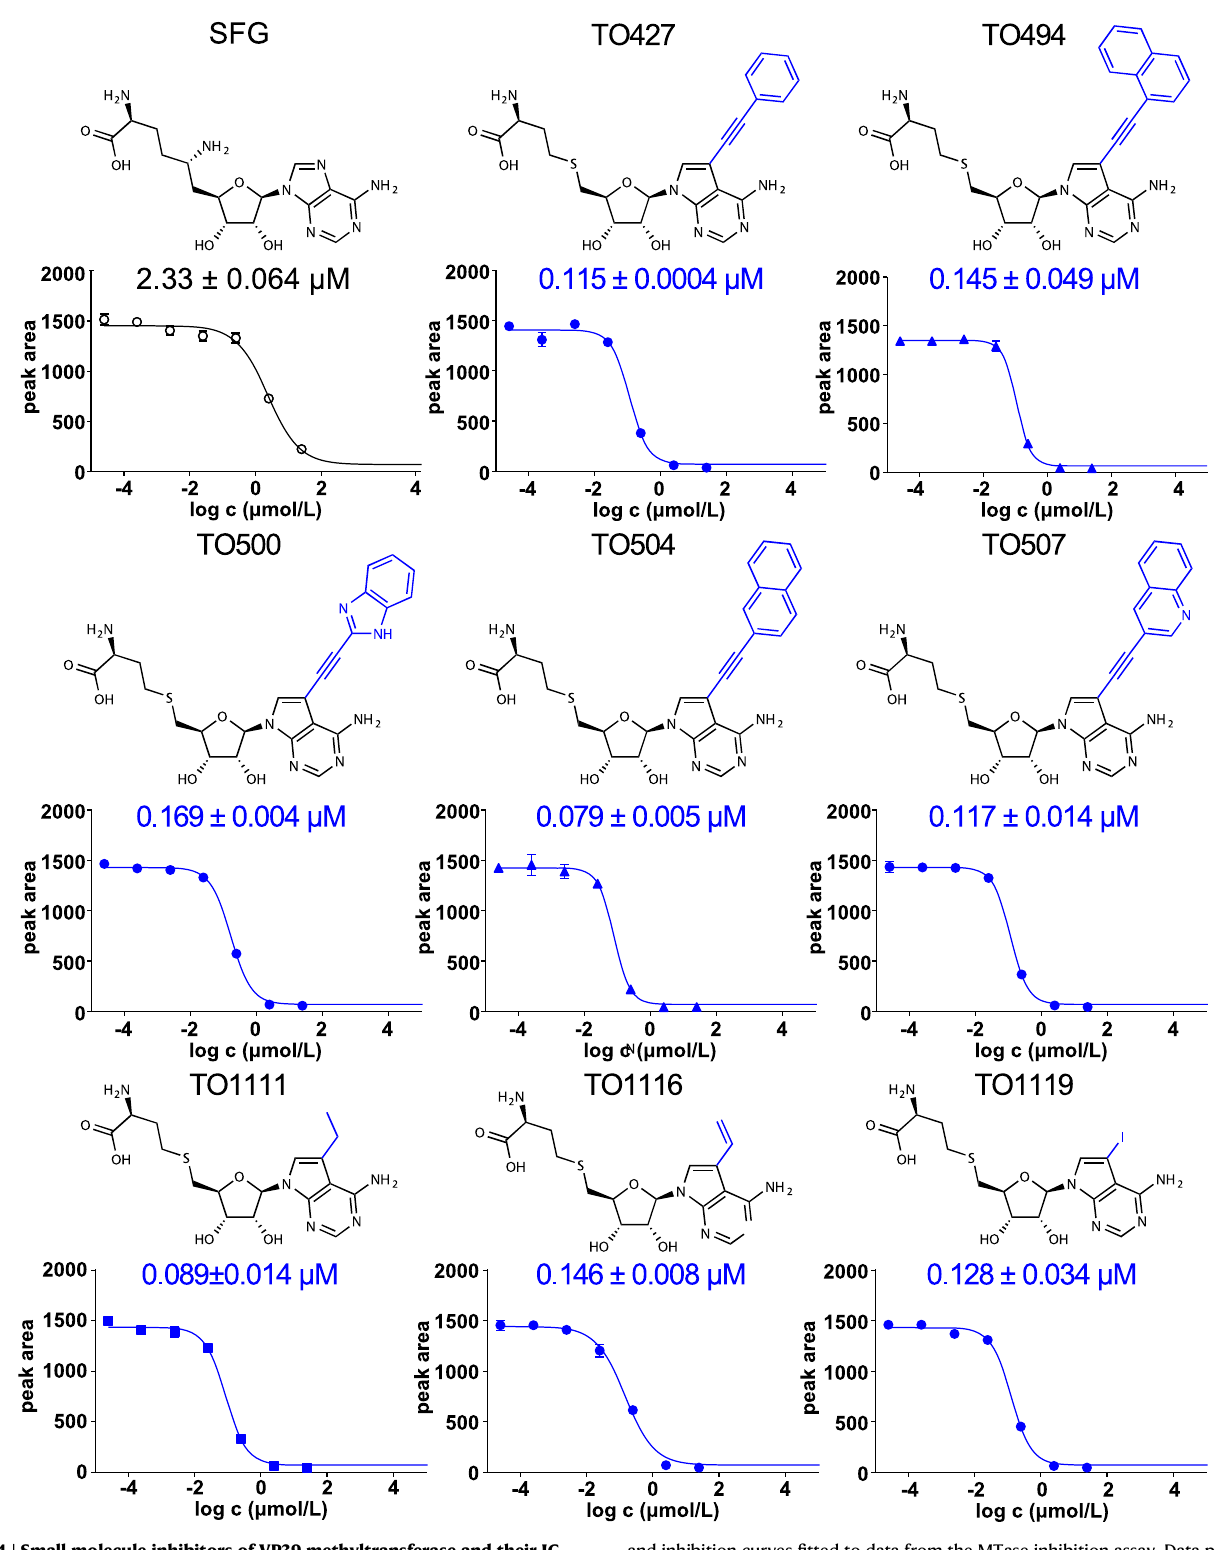
and inhibition curves fi tted to data from the MTase inhibition assay. Data points and IC 50 values are presented as mean values ± SEM ( n =2 independent measure- ments). Source data are provided as a Source Data fi